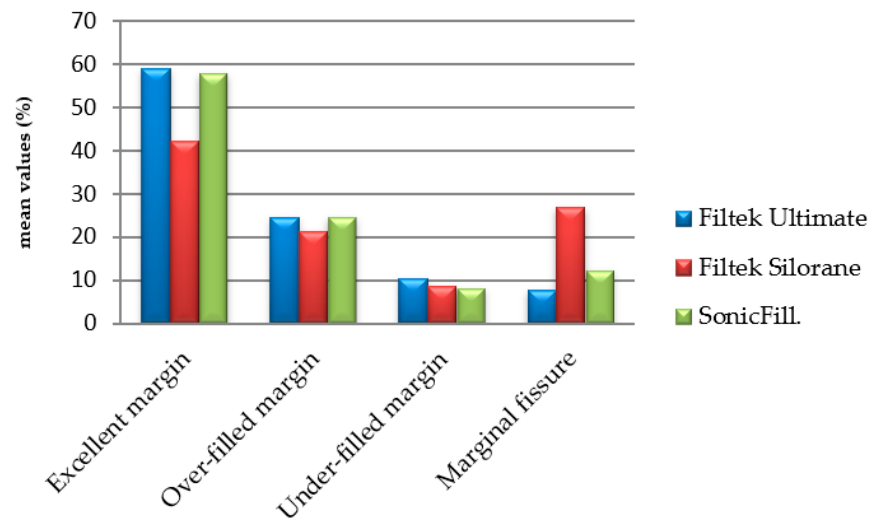
Figure 4. Marginal adaptation to the vestibular/lingual margins—results represented according to averaged mean values for both margins.